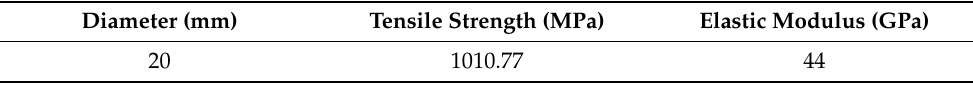
Figure 1 . Bamboo fiber. ( a ) Bamboo fiber appearance; ( b ) DR scan image of bamboo fiber. Table 3. Mechanical properties of the BFRP